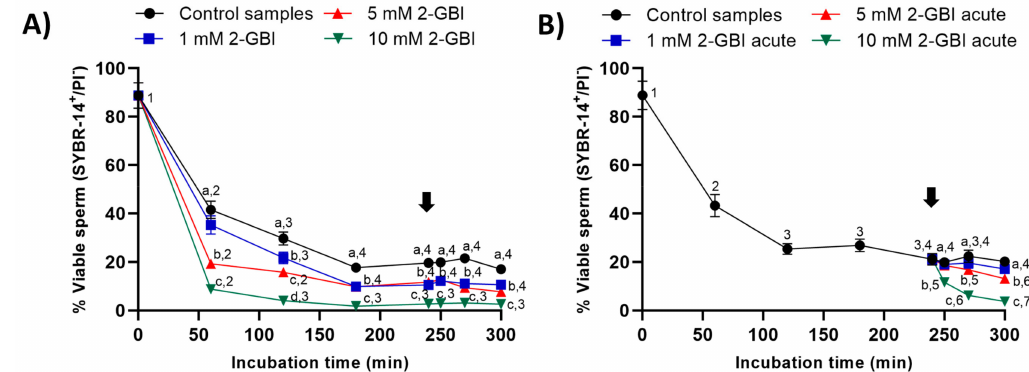
Figure 6. Percentages of viable sperm (SYBR14 + / PI - ) throughout the incubation of sperm samples in capacitating medium (control samples) and capacitating medium plus 1 mM, 5 mM or 10 mM 2-GBI. The blocker was added to capacitating medium either at 0 min in experiment 1 ( A ) or after 240 min of incubation in experiment 2 ( B , acute). Di ff erent superscript letters (a–d) indicate significant di ff erences ( p < 0.05) between samples within the same time point, and di ff erent superscript numbers (1–7) indicate significant di ff erences ( p < 0.05) between time points within a given treatment. Results are expressed as mean ± SEM ( n = 10). The arrow indicates the time at which 10 µ g / mL of progesterone was added to all samples (i.e., 240 min of incubation).